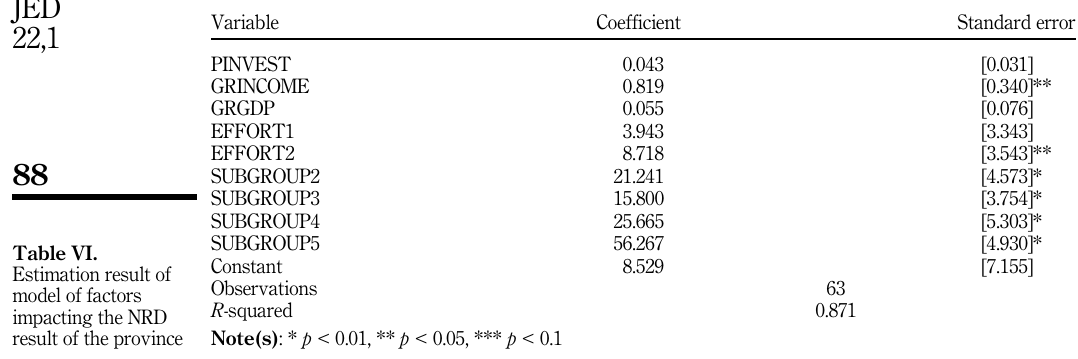
Table VI. Estimation result of model of factors impacting the NRD result of the